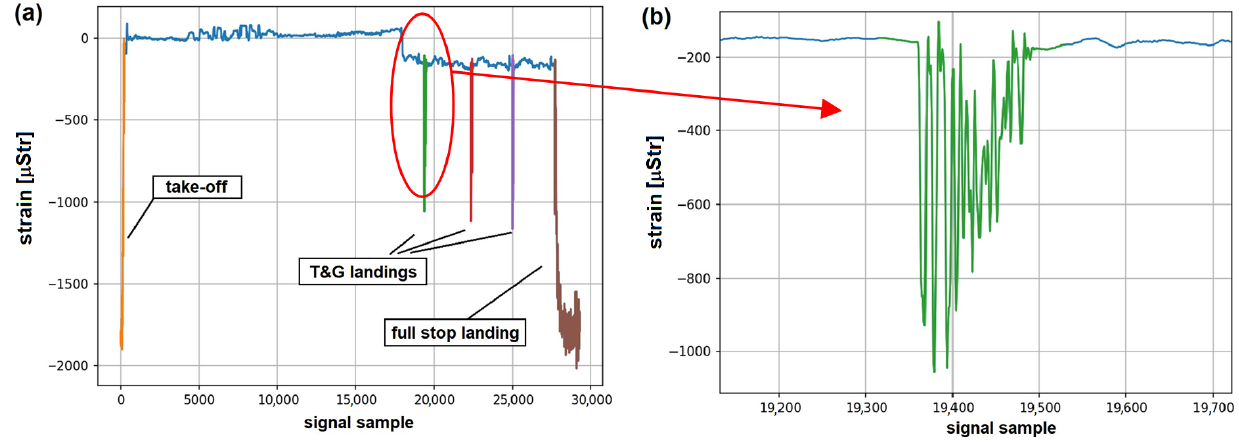
Figure 9. An example of load monitoring system records: ( a ) full record with indication of all detected on-ground operations;